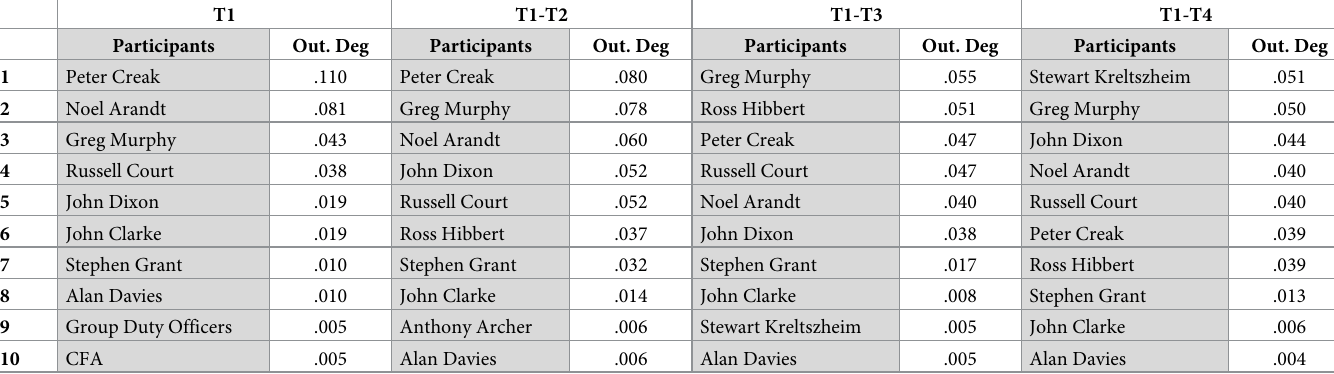
Table 3. Top 10 seeker personnel in Kilmore East inter-personal coordination network (normalized out-degree centrality).